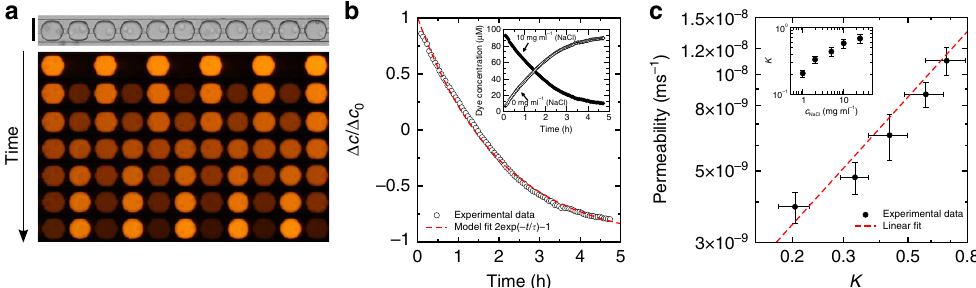
Figure 6 | Emulsion-based targeted delivery. ( a ) White-light picture of an immobilized row of droplets and time sequence of fluorescence signals (0, 0.5, 1, 1.5, 2, 2.5, 3h after immobilization, scale bar, 100 m m). ( b ) Relaxation of the concentration difference towards the opposite composition. A complete inversion of the concentration is obtained according to an exponential relaxation for droplets initially containing 100 m M resorufin sodium salt and 10mgml (cid:2) 1 sodium chloride (filled circles, see inset) and millipore water droplets (empty circles, see inset). ( c ) Dependency of permeability P on the partitioning coefficient K : the transport rate is driven by the largest partitioning coefficient in the system. Inset: dependency of partitioning coefficient K on the salt concentration in the aqueous phase c NaCl (error bars are standard deviation over three experiments).